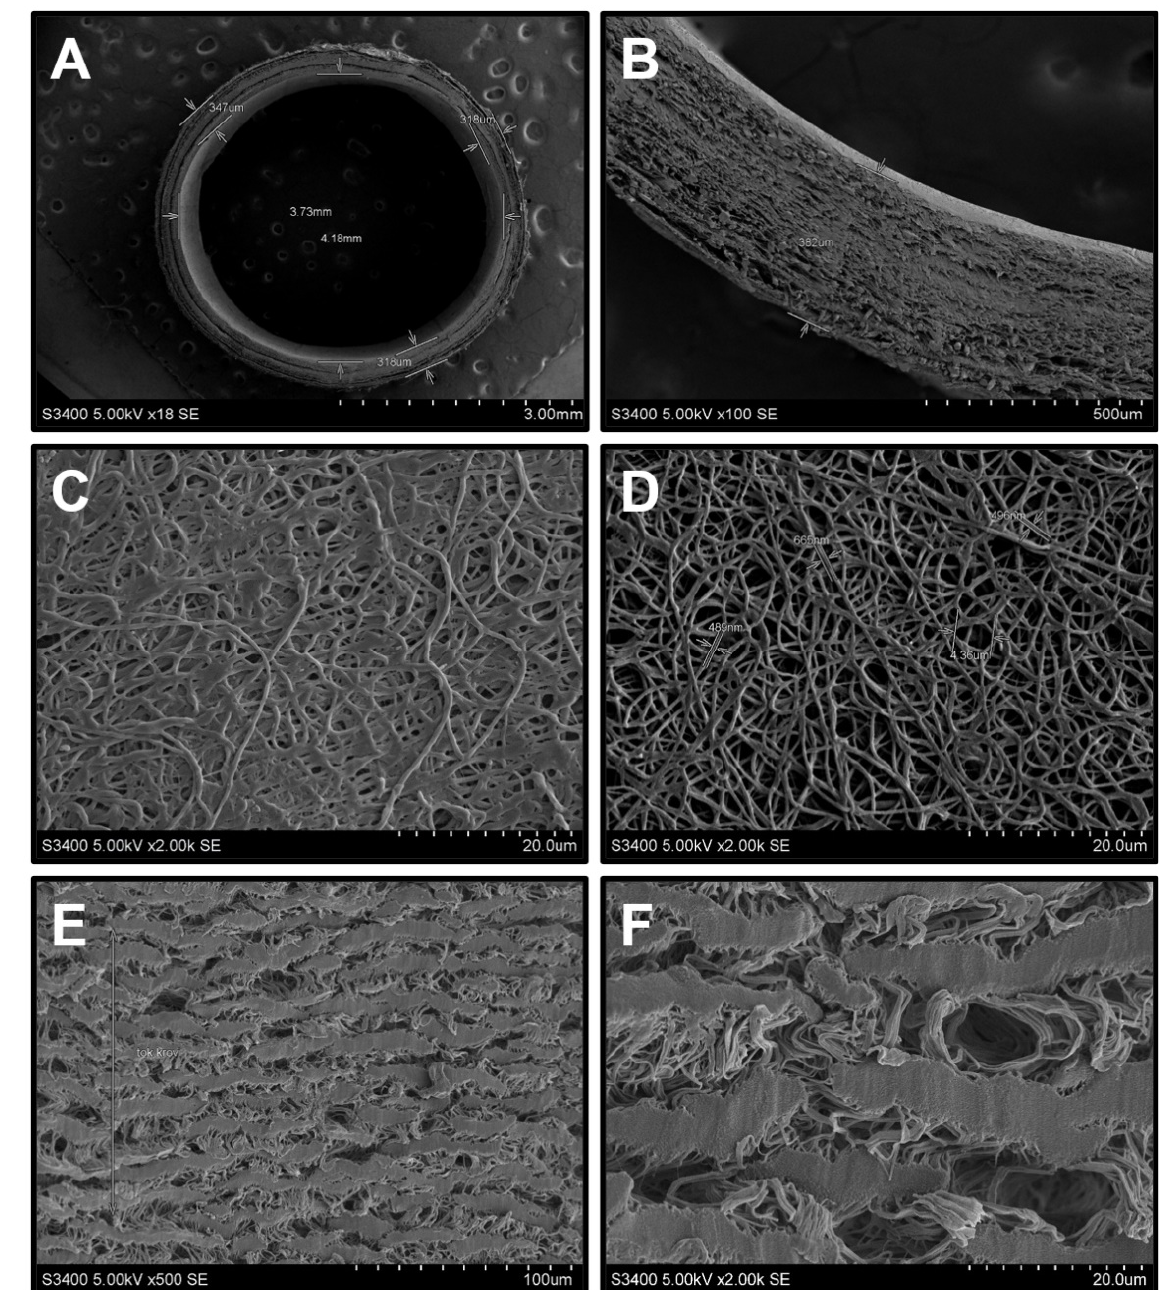
Figure 1. Scanning electron microscopy of biodegradable and synthetic vascular grafts: ( A ) Layer-by-layer hierarchical structure of the PHBV/PCL[VEGF-bFGF-SDF] Hep/Ilo grafts, view from above, × 18 magnification; ( B ) Layer-by-layer hierarchical structure of the PHBV/PCL[VEGF-bFGF-SDF] Hep/Ilo grafts, side view, × 100 magnification; ( C ) Luminal surface of the PHBV/PCL[VEGF-bFGF-SDF] Hep/Ilo grafts before the washing from PVP, × 2000 magnification; ( D ) Luminal surface of the PHBV/PCL[VEGF-bFGF-SDF] Hep/Ilo grafts after the washing from PVP, × 2000 magnification; ( E ) Luminal surface of ePTFE tubular scaffold, × 500 magnification; ( F ) Luminal surface of ePTFE tubular scaffold, × 2000 magnification. Representative